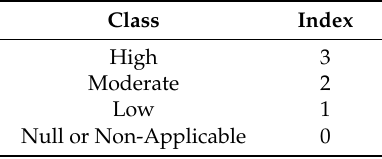
Table 1. Hazard reclassification